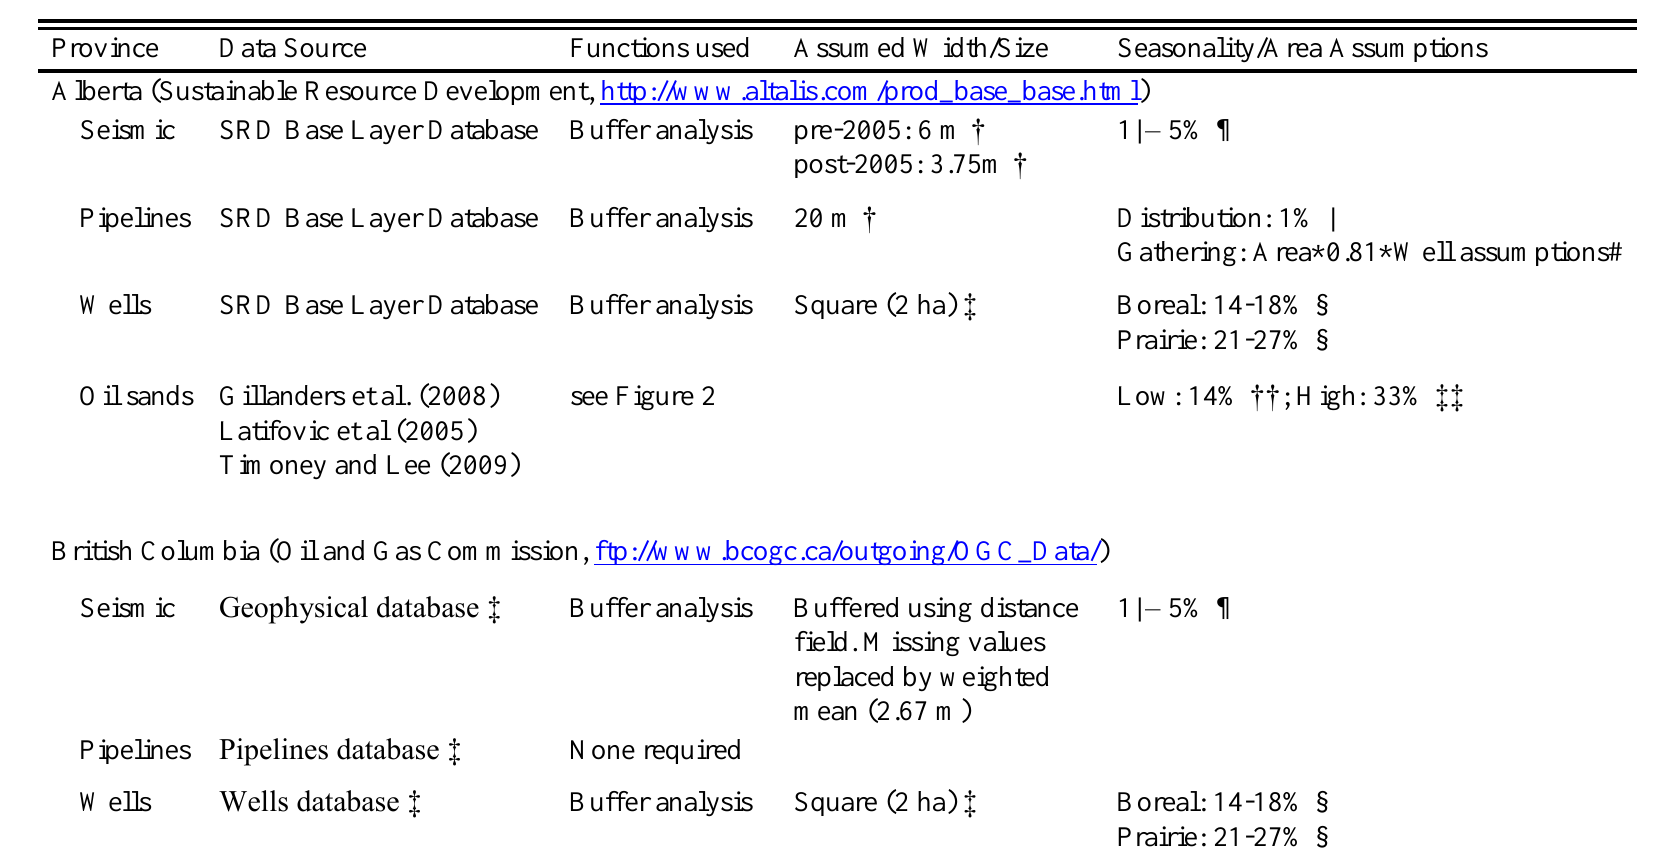
Table A1.1 Summary of data sources, analyses, functions, and assumptions used to derive estimated area disturbed during the annual breeding season of migratory birds in the Western Canadian Sedimentary Basin by jurisdiction and